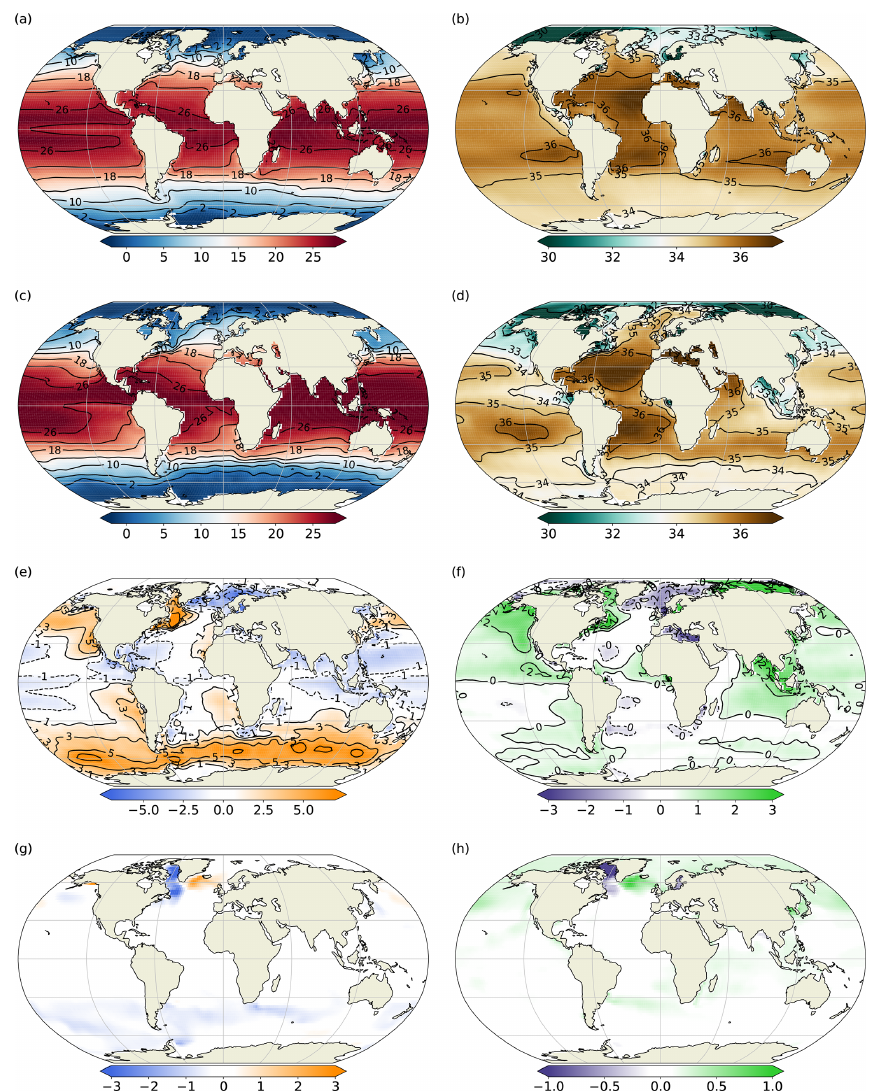
Figure 8. Time mean (years 2001–2025) SST and SSS for FORTE 2.0 L35 (a, b) and for EN3 (c, d) . Panels (e) and (f) show FORTE 2.0 L35–EN3 SST and SSS anomalies, respectively, whilst panels (g) and (h) show SST and SSS anomalies for